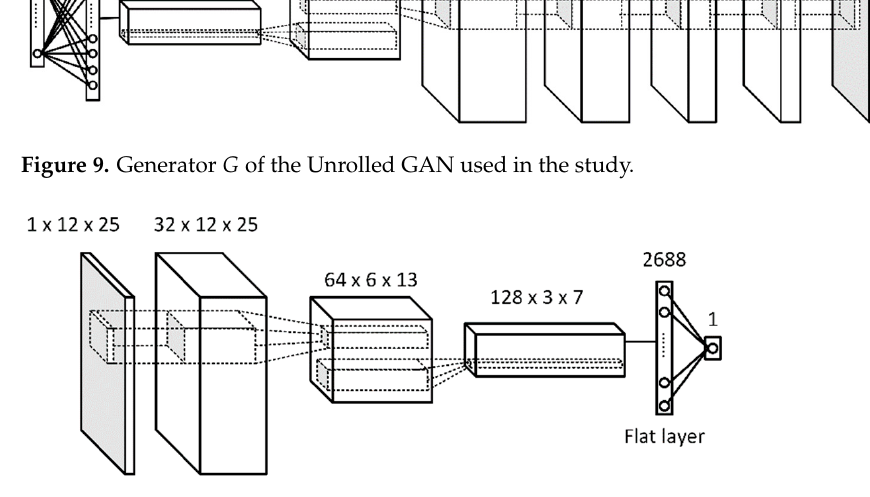
Figure 10. Discriminator (cid:1830) of the Unrolled GAN used in the study.